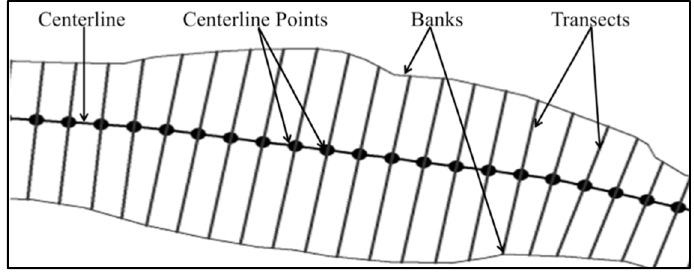
Figure 2. The river polygon, centerline, centerline points, banks, and transects as used extract sinuosity, slope, fractal dimension, and stream width.